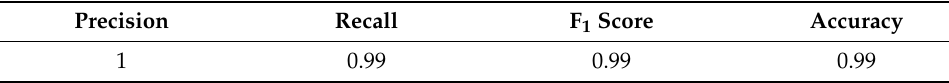
Table 5. Performance metrics of the validation images.